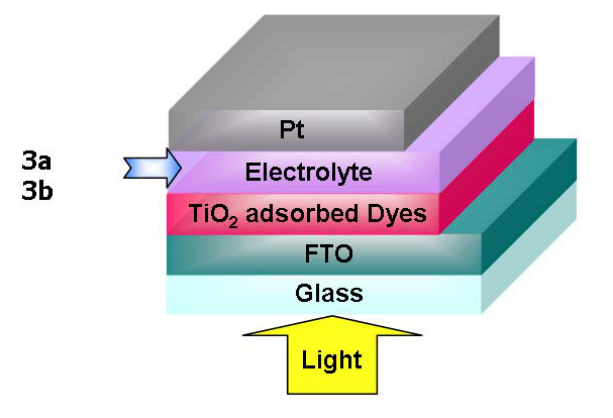
/N3 Dye/Electrolyte/Pt device using 3a and 3b 2